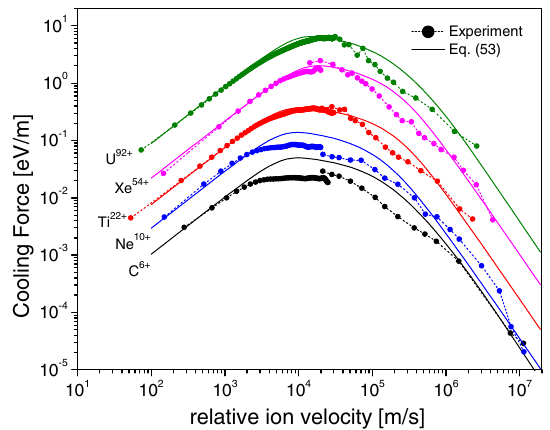
FIG. 8. Longitudinal cooling force (in eV = m ) for various fully stripped ions as a function of the relative ion velocity (in m = s ). Filled circles: Experimental data from measurements at the electron cooler of the ESR storage ring [28–30]. Solid curves: Eq. (54). The theoretical predictions of the cooling force are ¼ 10 6 cm (cid:1) 3 , T ¼ calculated for an electron beam with n ? e 0 : 11 eV , and T ¼ 0 : 1 meV in a magnetic field of B ¼ 0 : 1 T , k and are fitted to the experimental results at low relative velocities by treating the quantities (cid:12) k , (cid:12) ? as free parameters (see the text for